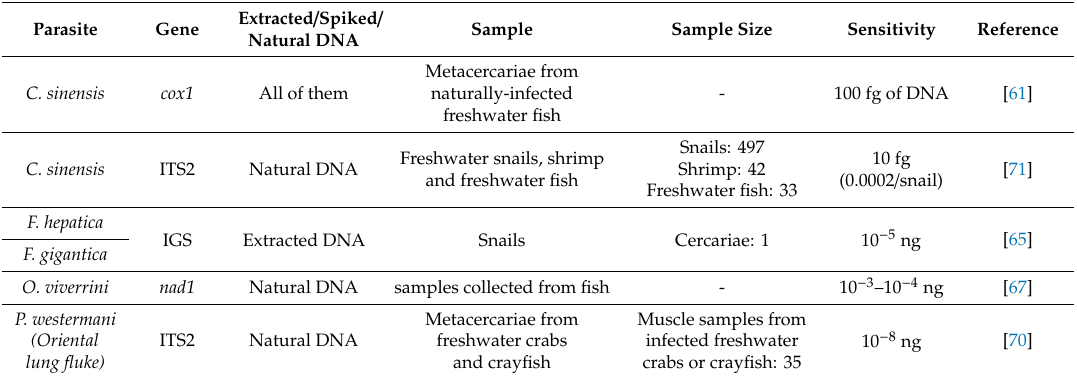
Table 5. Publications found in the US National Library of Medicine National Institutes of Health (NCBI-PubMed) reporting the standardisation of the LAMP technique as a useful tool for diagnosing foodborne trematodiases in the intermediate